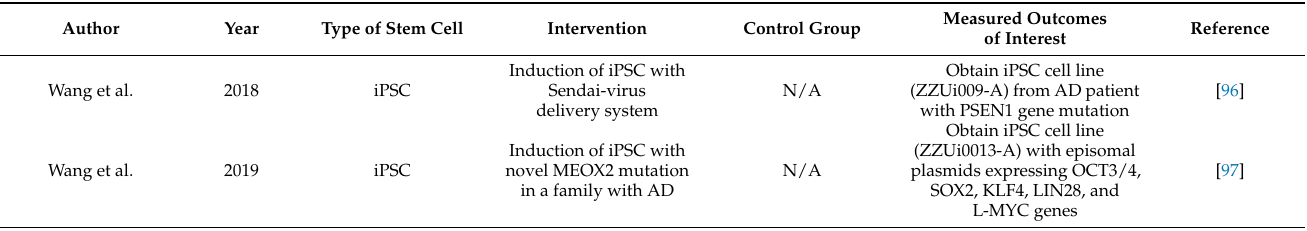
Table 3. Summary of clinical level studies on stem cell therapy for AD in chronological order